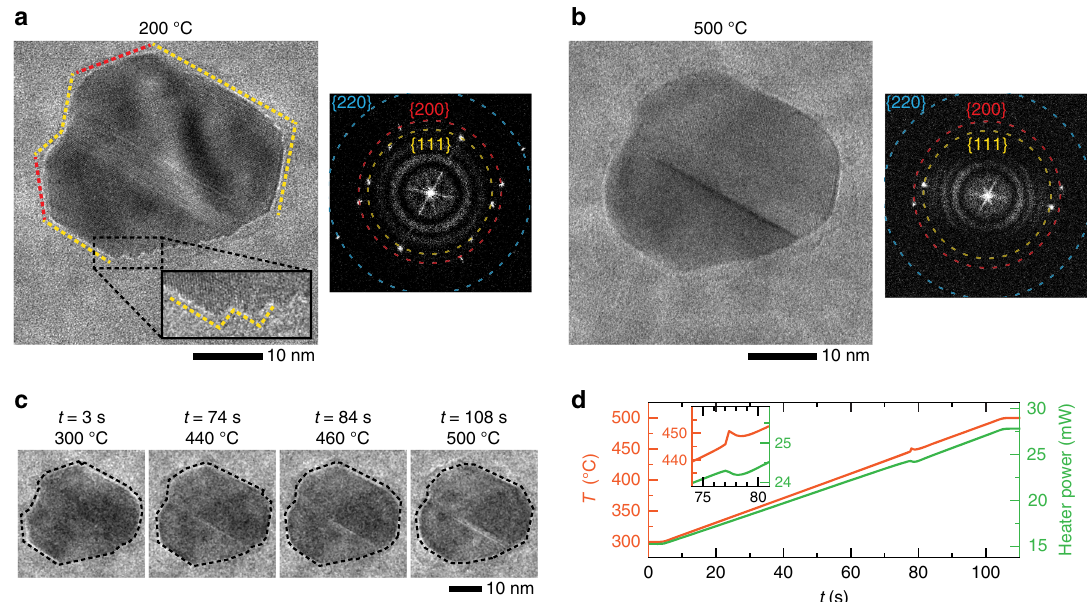
Fig. 2 Detailed results for the experiment described in Fig. 1. a Higher magni fi cation images of the NP in Fig. 1b at 200 °C and under 760 Torr of 9% CO, ¼ 0 : 5 , and its corresponding fast Fourier transform. The low index facets are highlighted with dashed lines of different colors 18% O 2 , and 73% He P CO P O 2 that correspond to re fl ections in the Fourier transform. Inset further magni fi es the step structure at the vicinal facet on the lower right of the NP. b Higher magni fi cation image of the NP after heating to 500 °C under 760 Torr of 9% CO, 18% O 2 , and 73% He gas. Notice the absence of sharp corners in the NP and the steps on the vicinal facet. c Image sequence extracted from a movie recorded during the temperature ramp from 300 to 500 °C (Supplementary Movie 1). The sequence shows the NP changing from a faceted morphology to a rounded one as the temperature increases. d Plots of the measured temperature (orange curve) and heater power (green curve) during the temperature ramp of 2 °C/s. The inset highlights a spike in the measured temperature and the corresponding reduction in heater power needed to compensate for the exothermic release of heat from the NPs ( y -axes have been re-plotted for the inset to accommodate both curves). For enlarged images of a and b , see Supplementary Fig.